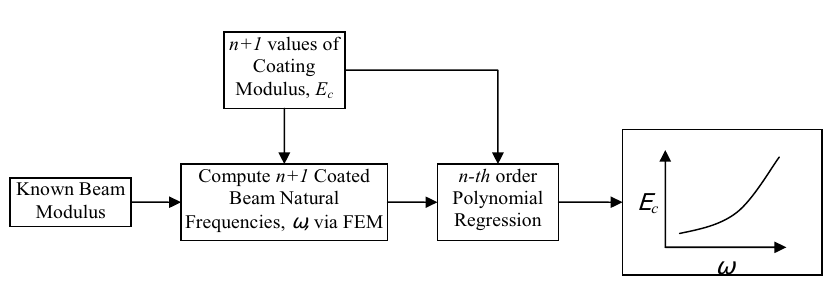
Fig. 10. Using a FEM based polynomial regression to find coating modulus.